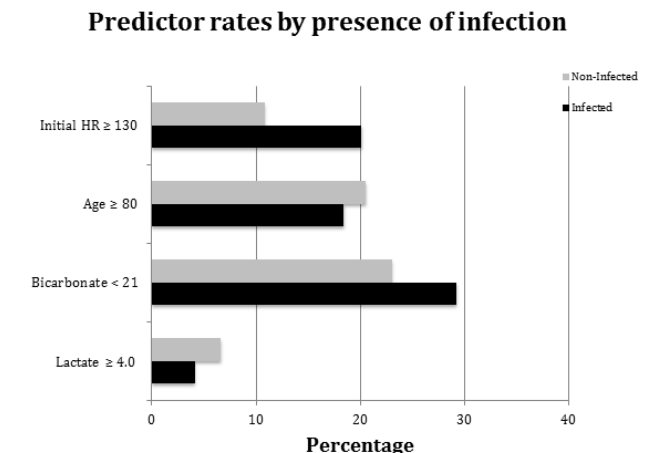
Figure 2. Percentage of model covariates in patients with and without infection.